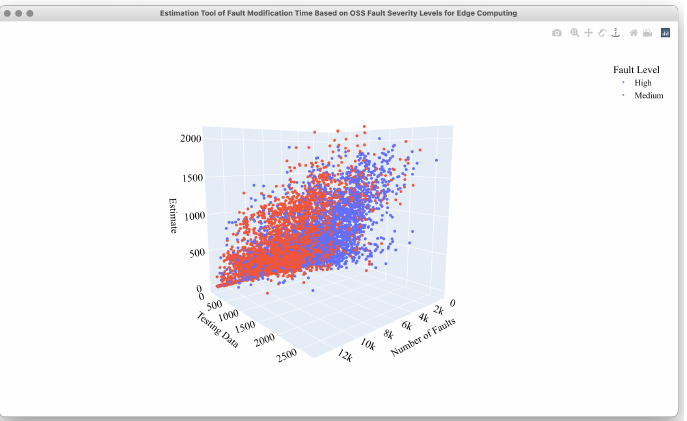
Figure 13. The overall picture of the estimated fault correction time in case of 30% testing data.